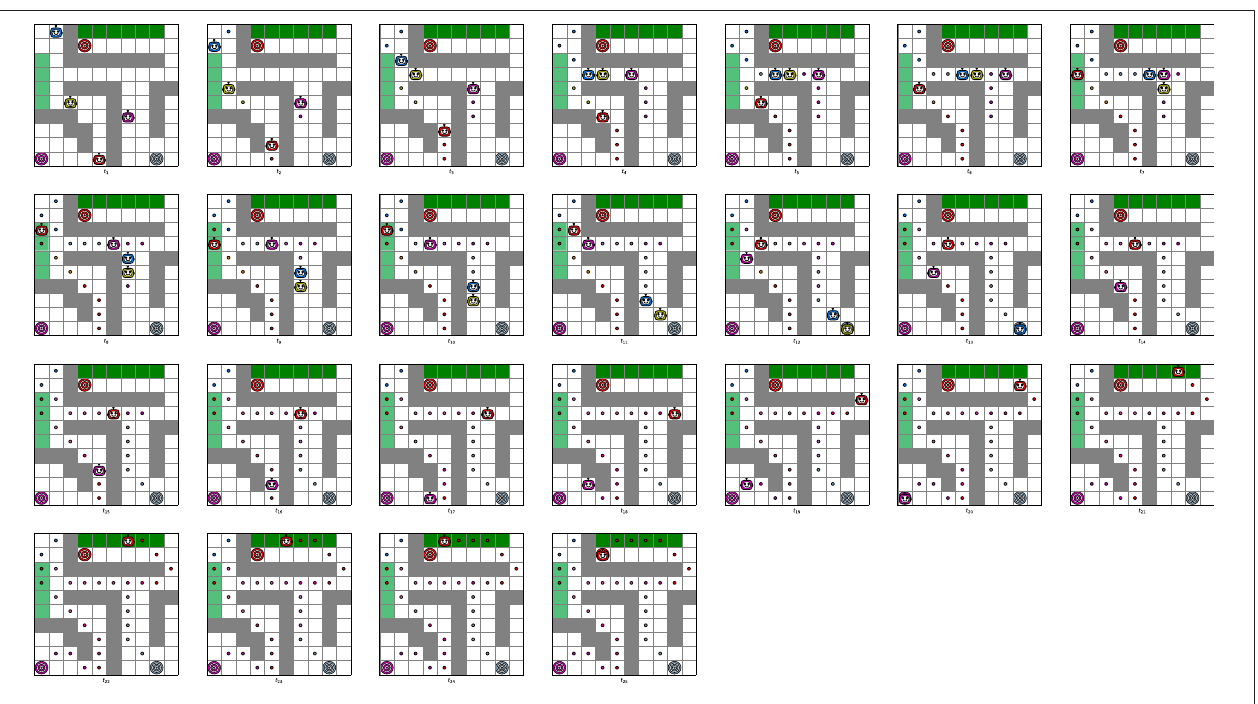
FIGURE 6 | Representation of the movement of four agents in a deterministic environment with eight possible actions { top-left, up, top-right, left, right, down-left, down,down-right